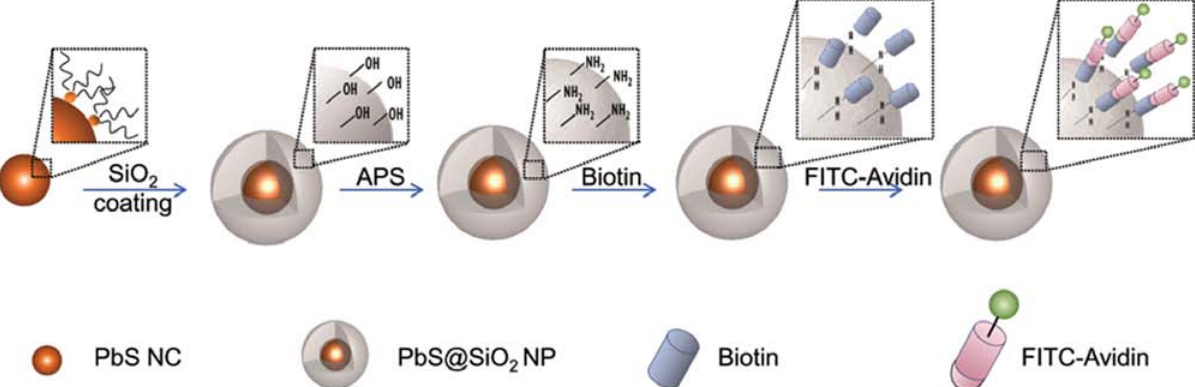
Fig. 5. General scheme for the PbS NC functionalization process leading to the conjugation of PbS@SNP with biotin and subsequent conjugation with streptavidin. Successive steps in sequence (from left to right): silica coating of organic capped PbS NCs; PbS@SNP surface modi¯cation with amine groups; bioconjugation reaction with biotin; molecular recognition with